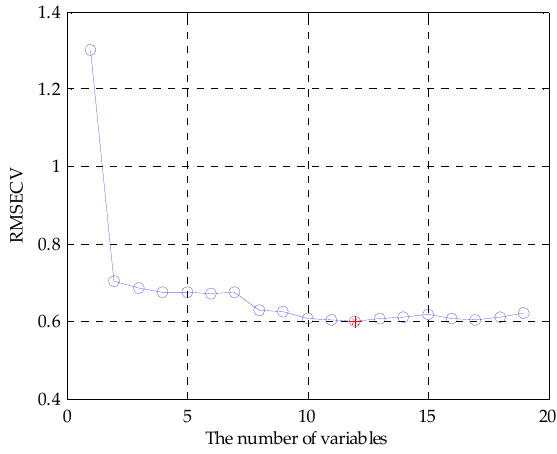
Figure 7. RMSECV change curve.